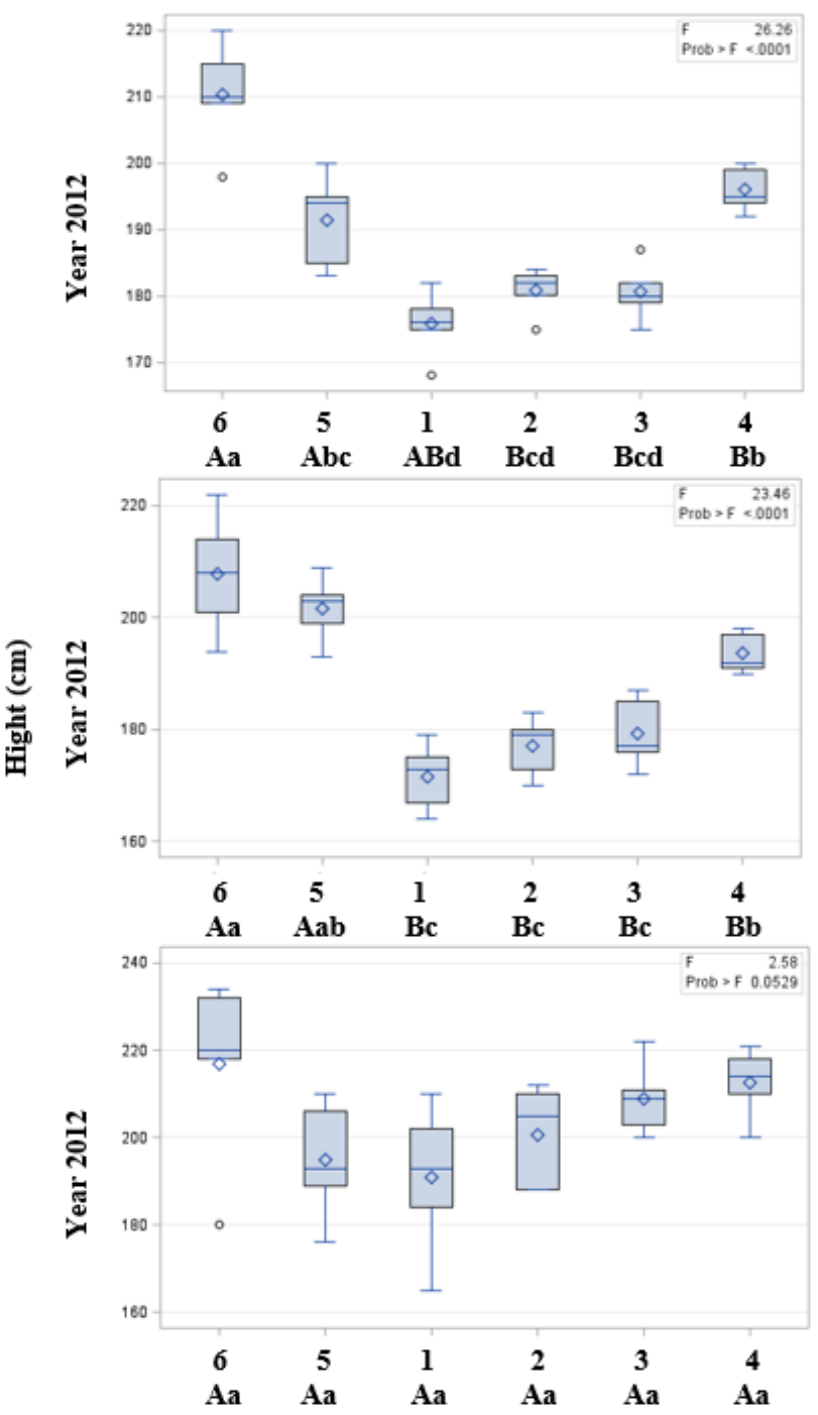
Figure 3. Distribution of tree height in subsequent years of research. Explanation: Means followed by the same letter are not significantly different at α = 0.05. The means marked with capital letters show significant differences between the years of research in particular combinations. Means marked with lowercase letters show significant differences between the combinations in particular years of research. 1 — Control; 2 — Fertilizer with biostimulation 1% — the herbicide belt; 3 — Fertilizer with biostimulation 1% — soaking 1 h; 4 — Fertilizer with biostimulation 1% — soaking 12 h; 5 — Agrogel; 6 — Fer- tilizer with biostimulation 1% +